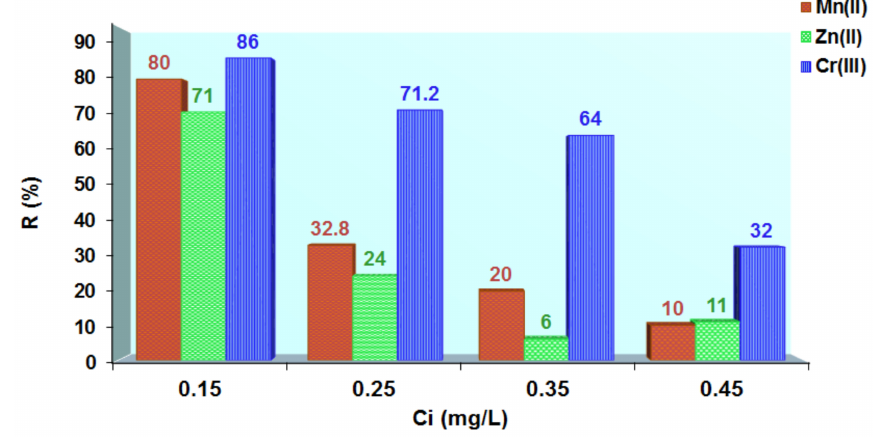
Figure 7. Metal ions removed from aqueous solutions using XAD7HP-AB